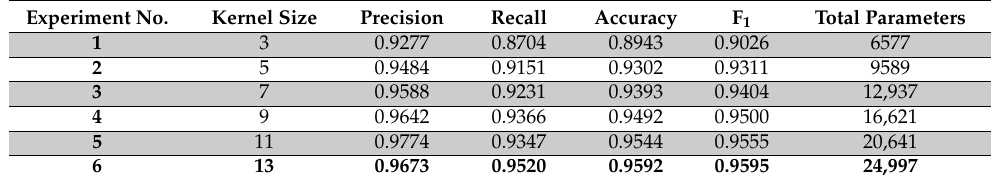
Table 7. Classification performance of the model for a single scale with different kernel